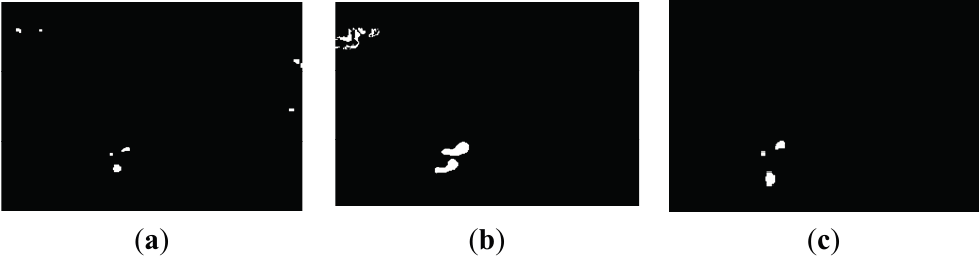
Figure 11. Suspected-abandoned object segmentation. ( a ) Dual-background segmentation image; ( b ) Dual-foreground segmentation image; and ( c ) Static foreground region image based on proposed dual-background difference algorithm.